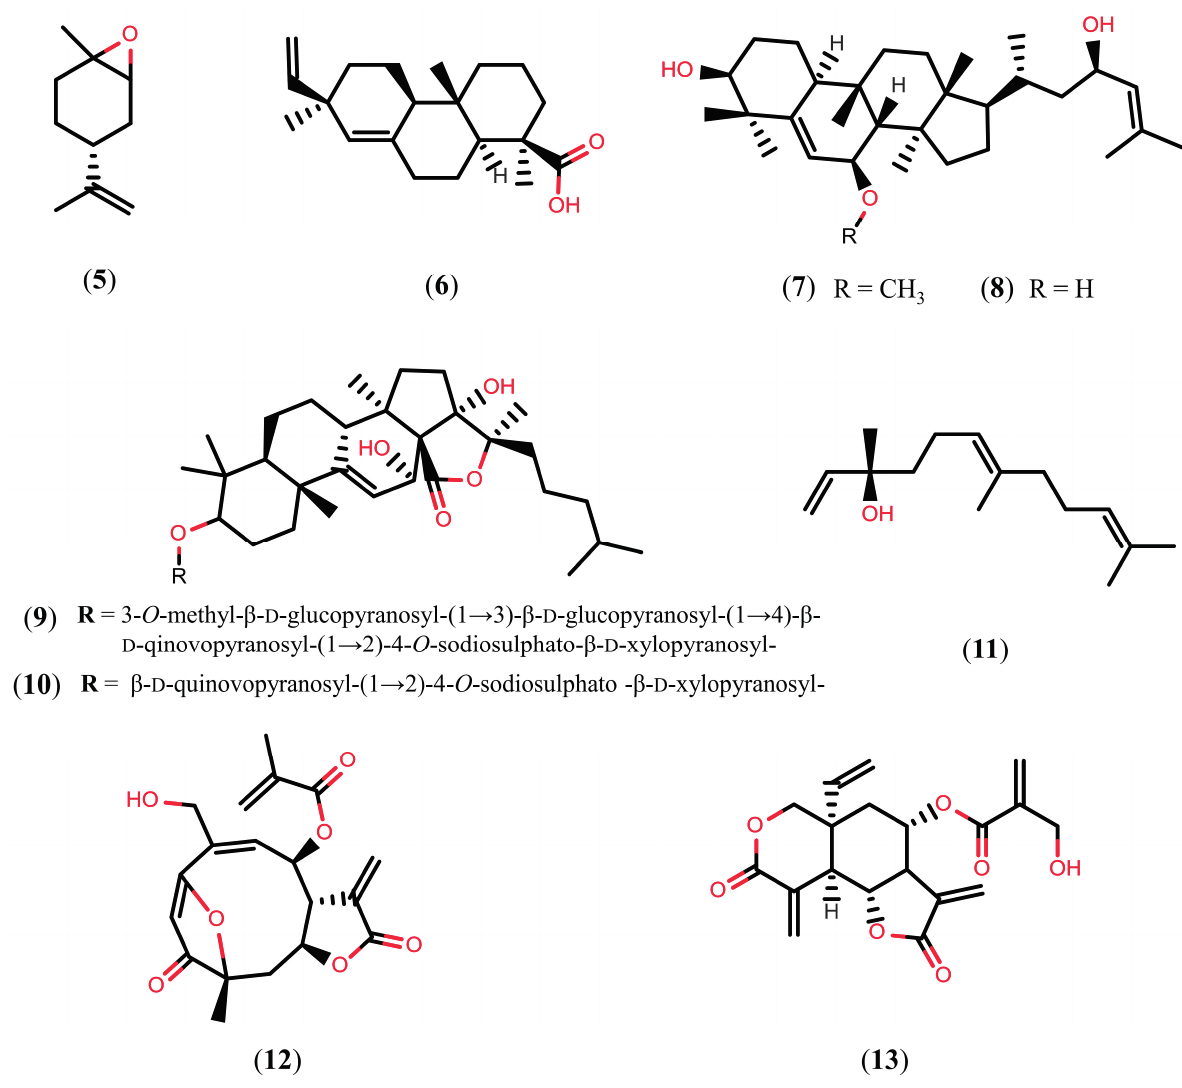
Figure 2. Chemical structures of terpenoids known to have schistosomicidal